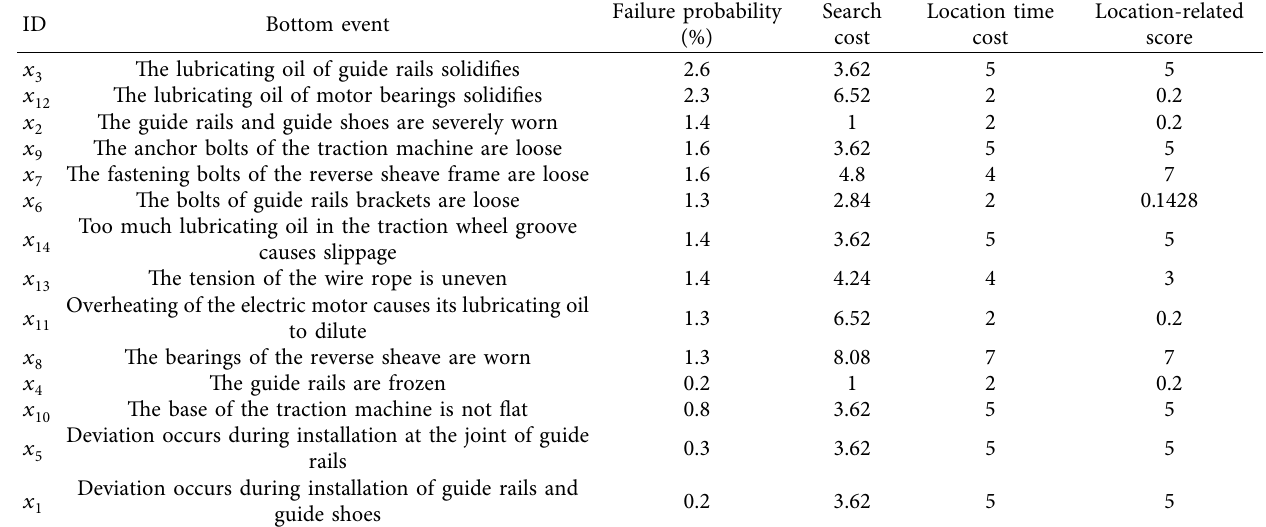
Table 5: Scores of four attributes.